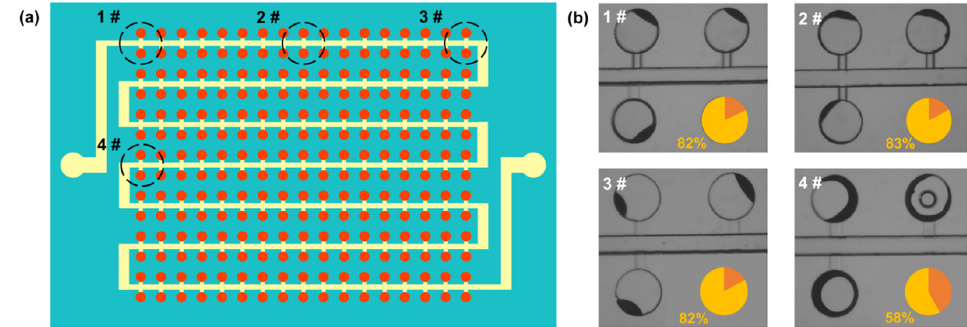
Figure 7. ( a ) Schematic of different evaluated locations in the cdPCR MFD with an S-shape main channel, the red color is the reagent, the yellow one is oil, and the Aquamarine color is PDMS chip. ( b ) Water loss percentage in the chambers at different distances from the ports and PDMS sidewall.